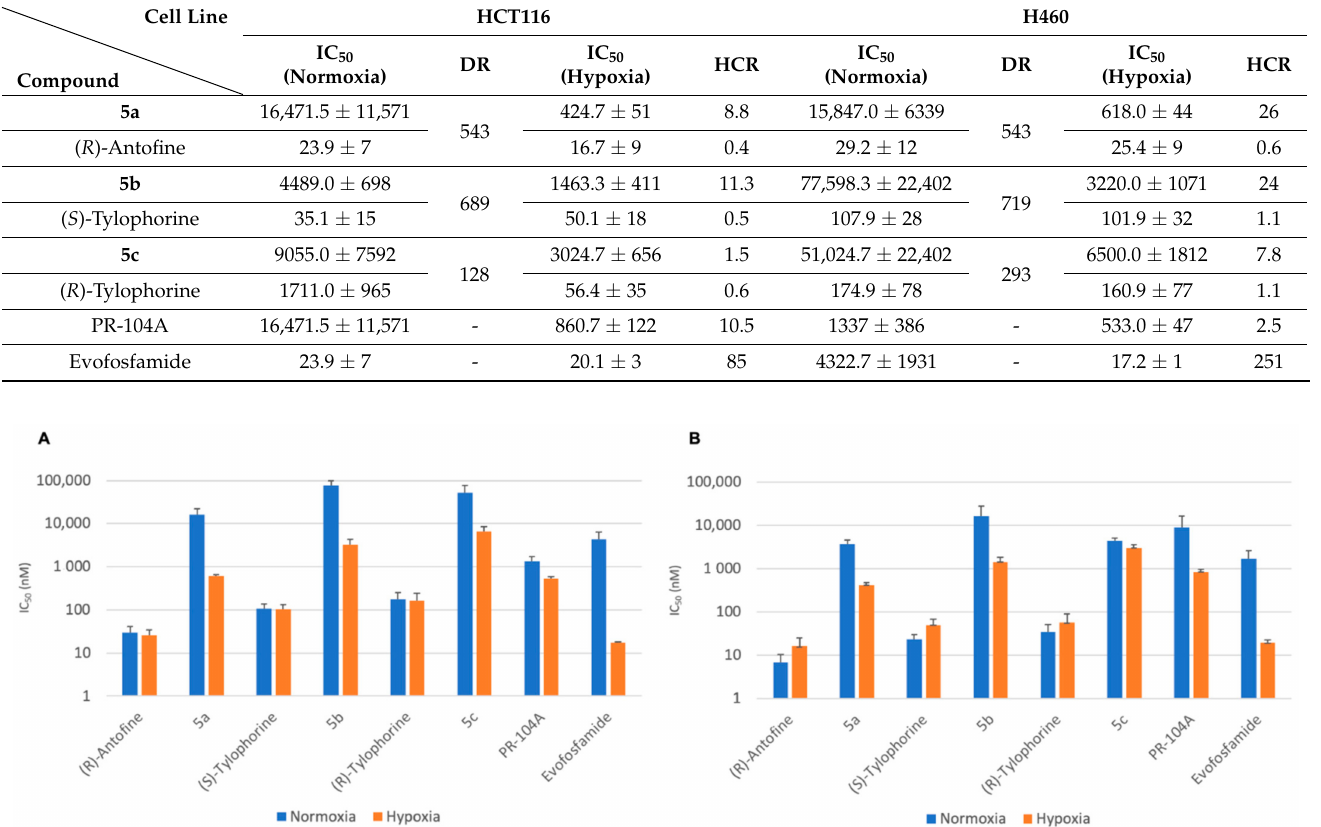
Figure 6. Cytotoxicity of compounds 5a – c and their parent alkaloids under normoxia and hypoxia against ( A ) HCT116 and ( B ) H460 (IC 50 ,